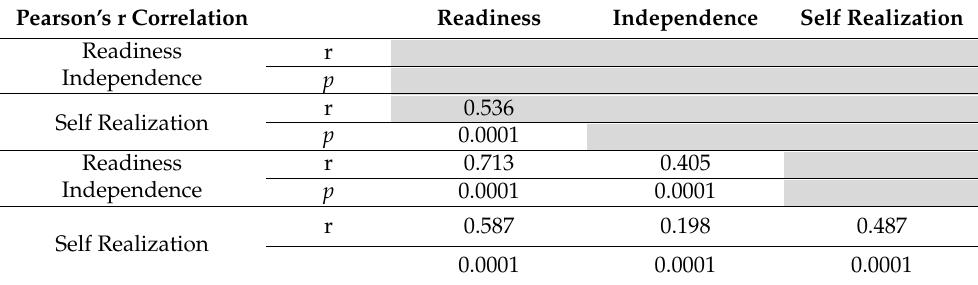
Table 11. Pearson’s r correlation between